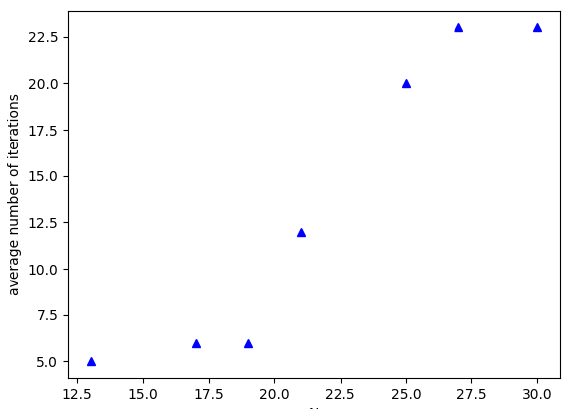
Figure 23. Average number of iterations needed in the implicit step in order to reach convergence, as a function of the number N of reduced basis for u f , p f , d s